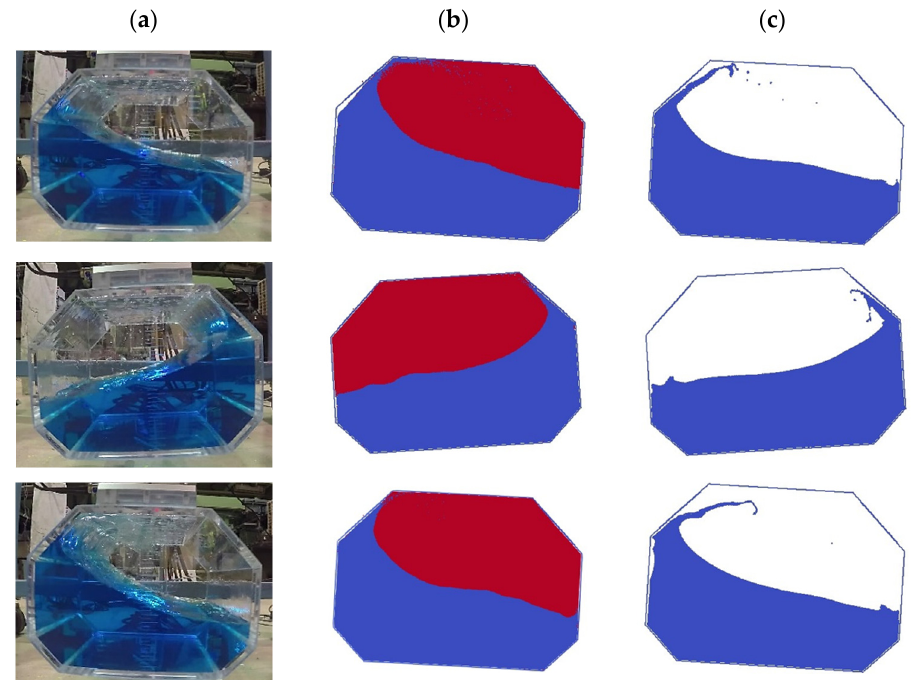
Figure 14. Free surface evolution of roll excitation in ( a ) the experiment, ( b ) two-phase, and ( c ) single-phase SPH with t = 3.6 seconds, 3.9 seconds, and 4.4 seconds.